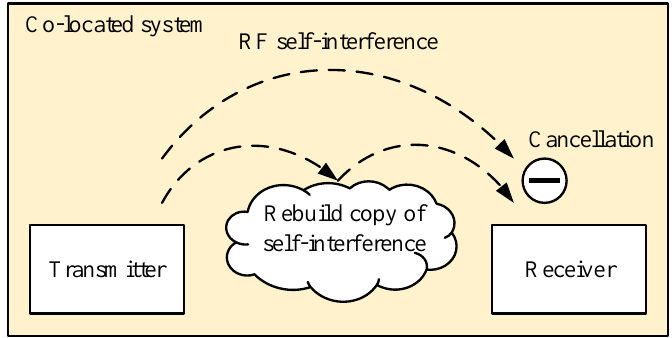
Figure 2. Operation mechanism of the SIC techniques.